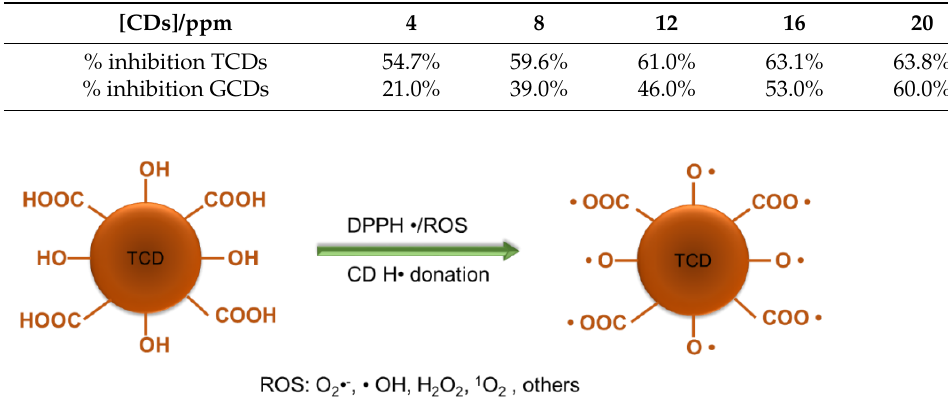
Figure 5. ( a ) Tauc plots for estimation of the TCDs bandgap and ( b ) Urbach energy estimation for GCDs.